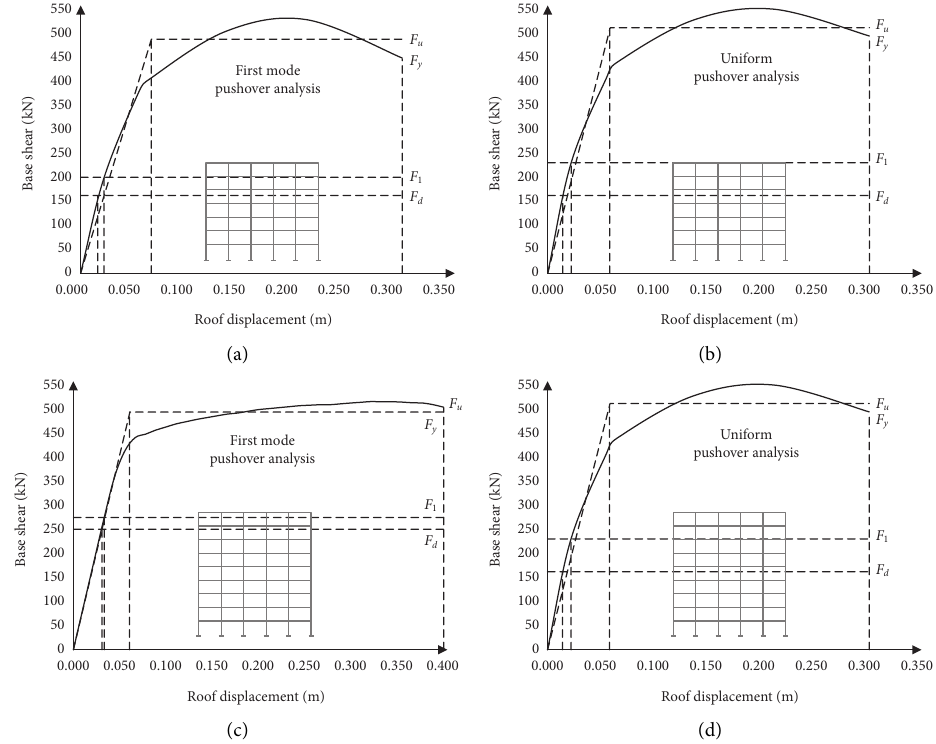
Figure 6: Base shear versus roof displacement. 7S5B and 9S5B